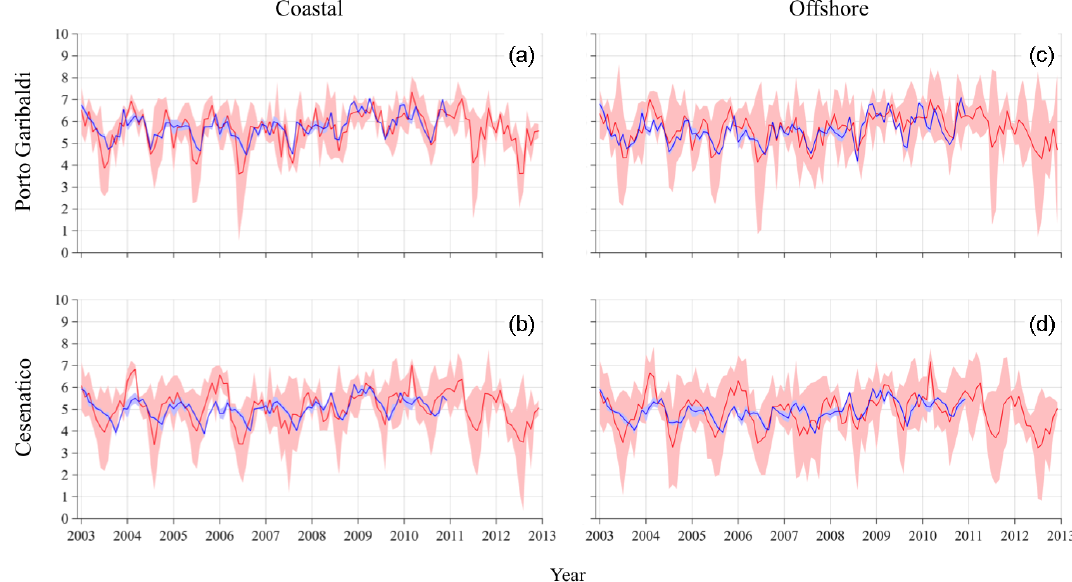
Figure 6. Comparison between in situ TRIX (red line) and model TRIX (blue line) averaged over two transects (Porto Garibaldi and Cesenatico), including stations up to 10km distance from the coast (coastal, a and b ) and up to 20km distance from the coast (offshore, c and d ). Red and blue shaded areas correspond to average values ± 2 standard